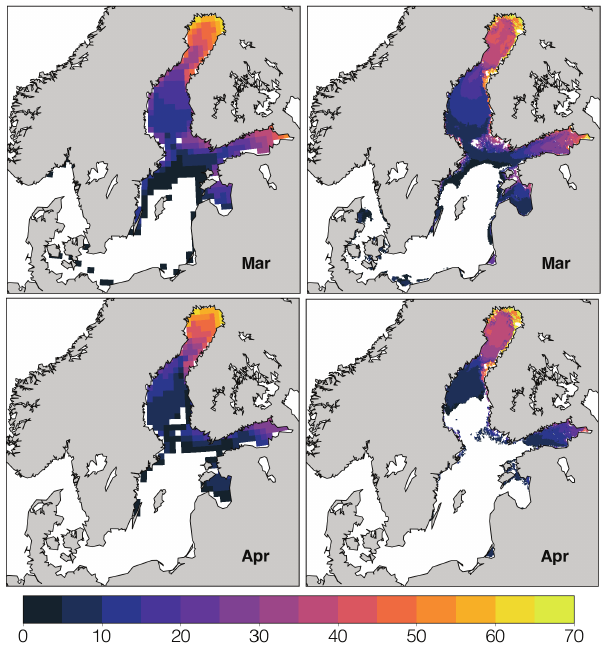
Figure 12. Climatological mean sea-ice ridge concentration in % for March and April, for the period 1961/1962–1978/1979. The left (right) column shows sea-ice ridge concentration for BASIS (NEMO-Nordic). For NEMO-Nordic the sea-ice ridge concentra- tion is estimated from the fifth ice category. The inset shows a zoom over the Bothnian Bay for the simulated March